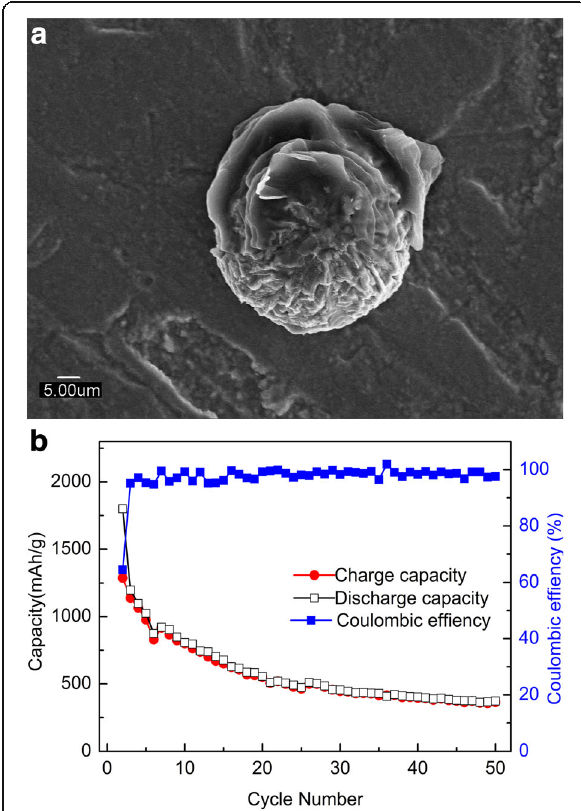
Fig. 6 a SEM image and b cycling performance of the Fe 2 O 3 film anode grown at 400 °C at a specific current of 100 mA g − 1